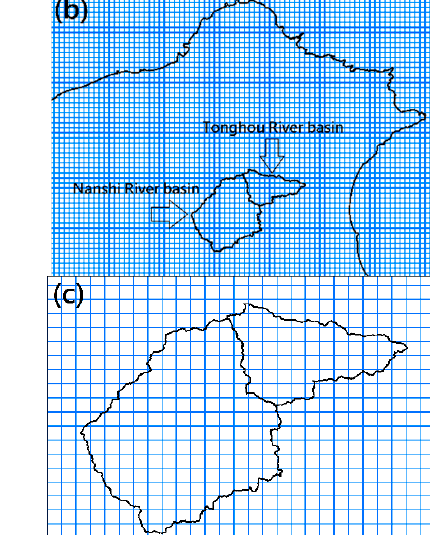
Figure 7. The 1.25 km by 1.25 km rainfall data grids (blue meshes) of quantitative precipitation estimation and segregation using multiple sensors (QPESUMS) and interpolated from the WRF model for ( a ) all of Taiwan, ( b ) an enlargement of northern Taiwan ,and ( c ) an enlargement of the Nanshi and Tonghou watersheds.